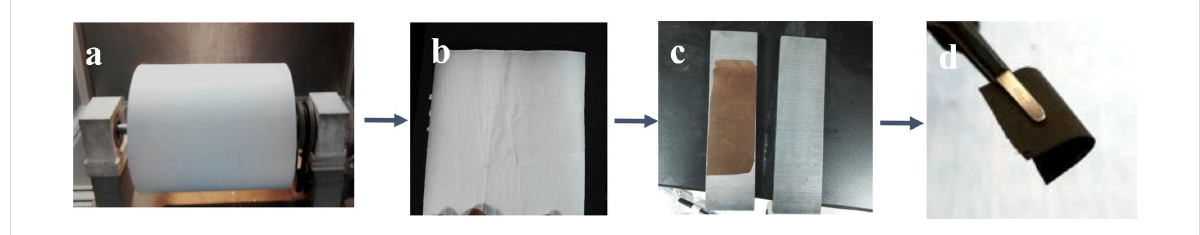
structure of the material remains unchanged even after many cycles